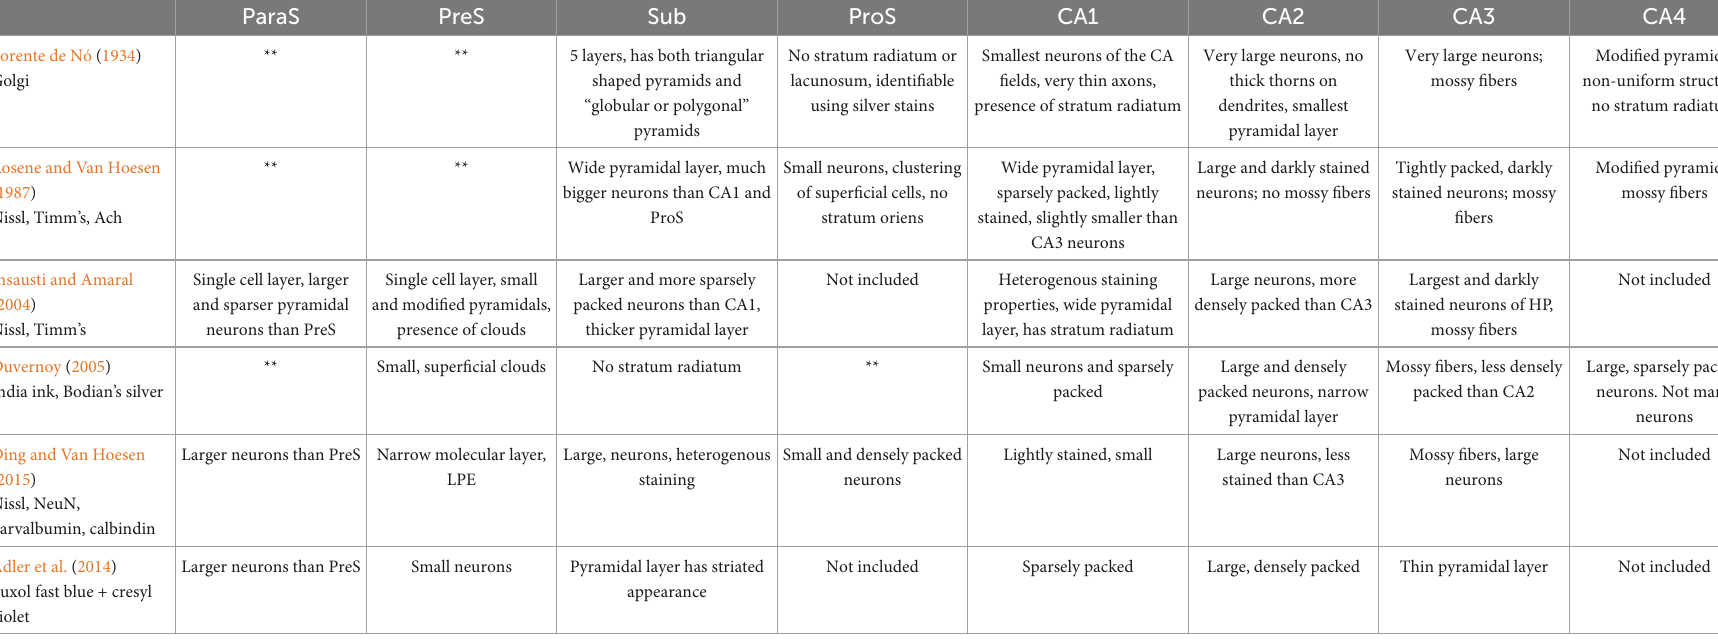
TABLE 2 Summary of previous seminal publications and their main observations (rows) on the histological characteristics of each hippocampal subfield